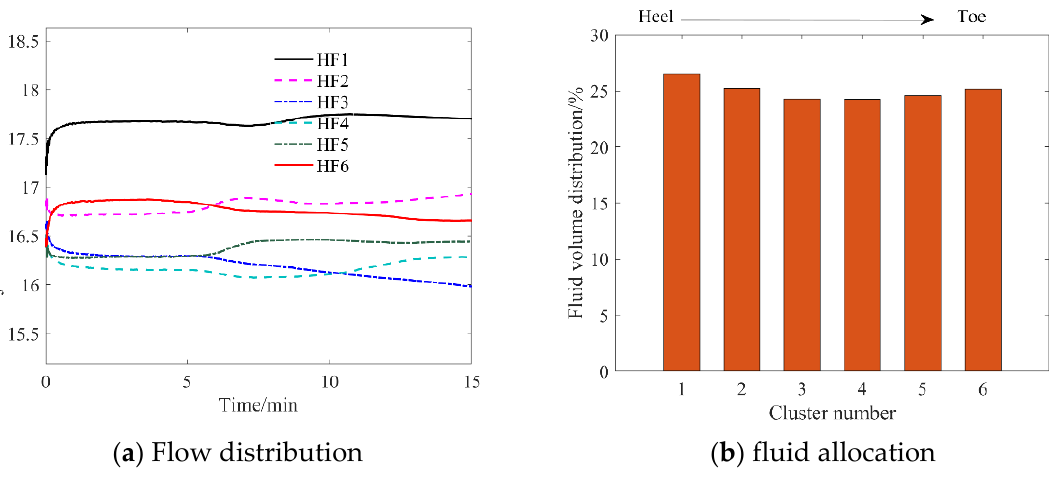
Figure 5. Flow distribution and fluid allocation of the base case group.